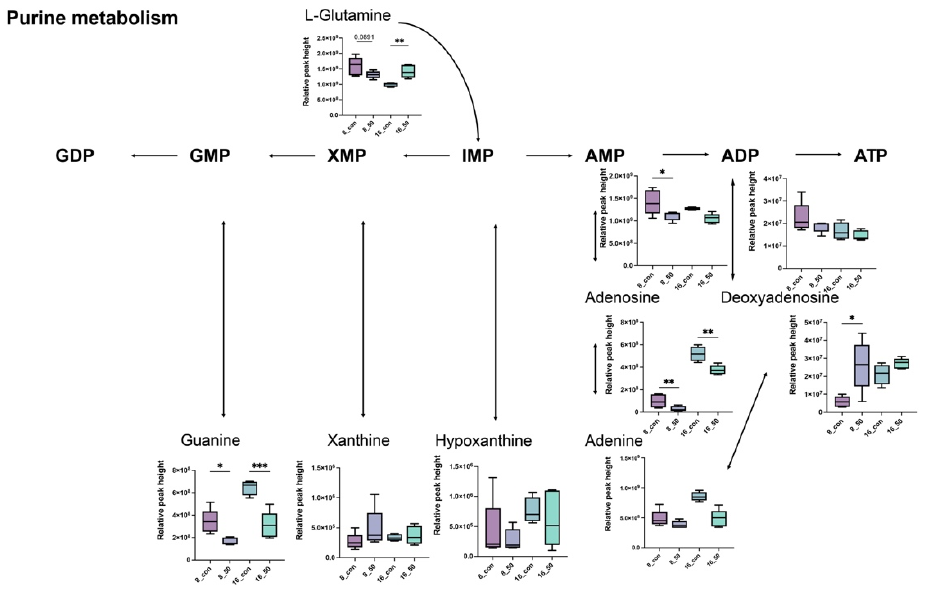
Figure 6. Enrichment diagram of the L. plantarum metabolic pathway after PAT exposure. ( A ) The 8 h group and ( B ) the 16 h group.